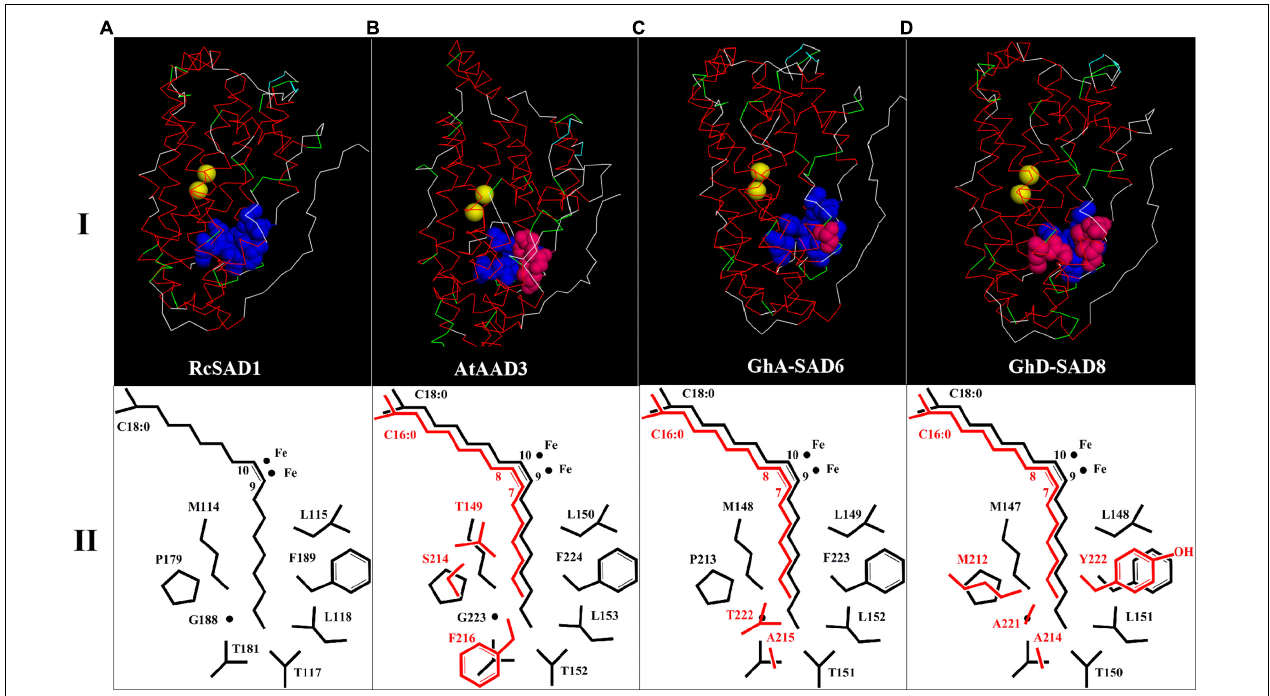
FIGURE 2 | 3D structure models of GhSAD protein monomers ( C,D , upper panel I) and C18:0/C16:0-ACP chains as well as side chains of key amino acids close to catalytic center of diiron ions (lower panel II). All 3D models were predicted on Swiss-model (https://swissmodel.expasy.org/) with RcSAD1 (NP_001310659.1) and AtAAD3 as temples (A,B) . Files of 3D structure of GhSADs were showed using Discovery Studio 4.1 software. Yellow bolls in upper panel I refer to diiron ions. Blue bolls/spheres refer to common amino acids as same as RcSAD1 while pink bolls refer to the varied amino acids. The fatty-acyl chains and side chains of amino acids were drawn by ChemDraw software (lower panel II). Black color represents C18:0-ACP and its common amino acids. Red indicates C16:0-ACP and varied amino